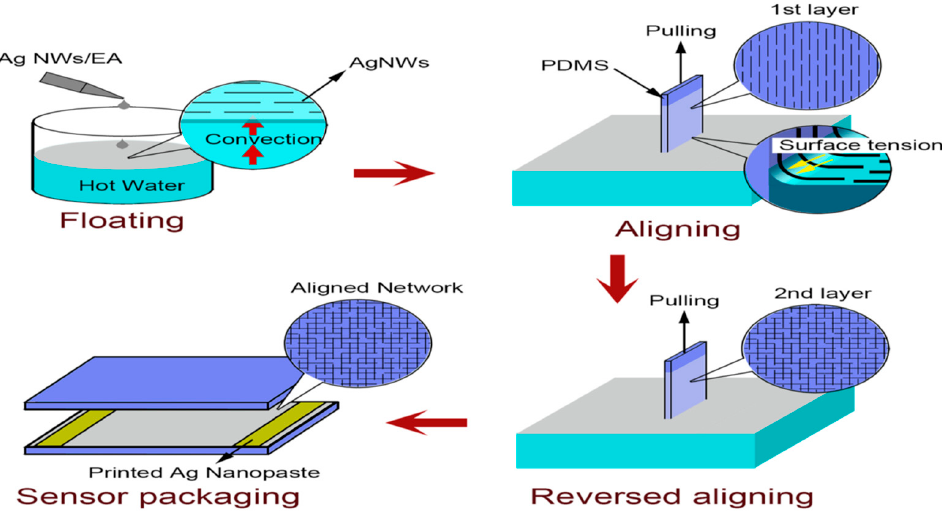
Figure 6. Fabrication steps in the water-bath pulling method. Adapted under the terms of the CC-BY 4.0 license from Ref. [69] Copyright 2019, The Authors, published by Nature Portfolio.